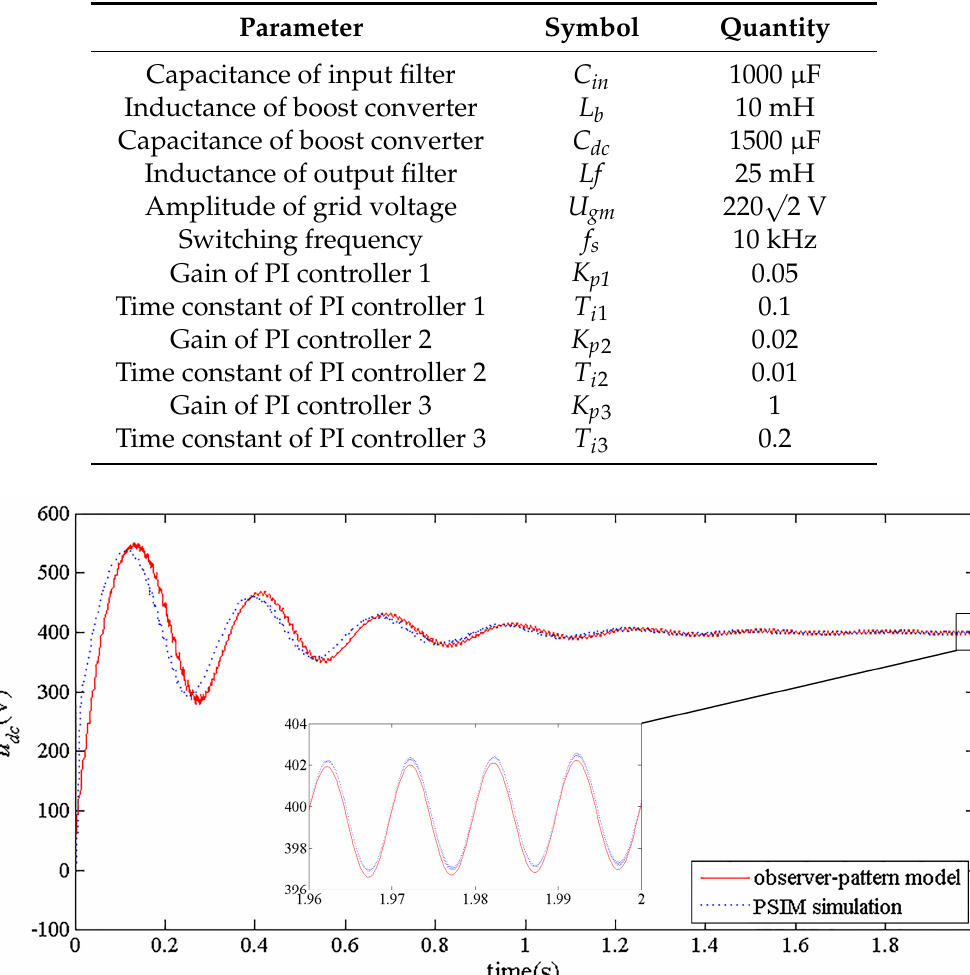
Table 2. Converter parameters.